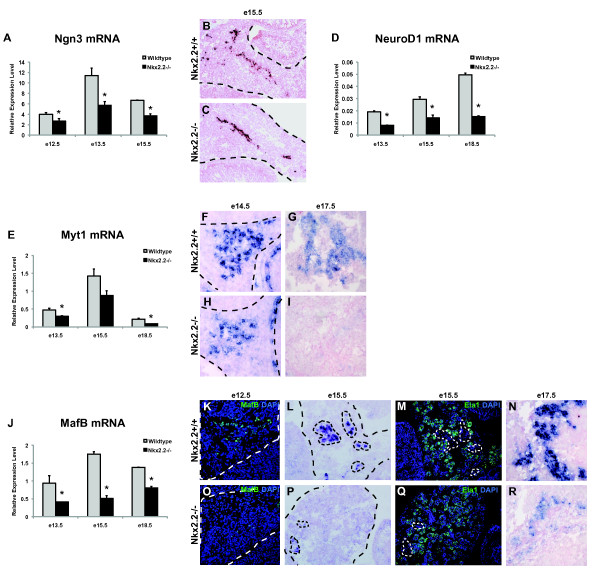
Loss of Nkx2.2 affects expression of critical early endocrine progenitor transcription factors; Ngn3, NeuroD1, Myt1, and MafB. qRTPCR of (A) Ngn3 levels were assessed at e12.5, e13.5, and e15.5; (D) NeuroD1, (E) Myt1, and (J) MafB transcript levels were determined at e13.5, e15.5, and e18.5 and all genes compared wild type (grey bars) and Nkx2.2-/- pancreata (black bars). In situ hybridization comparing wild type and Nkx2.2-/- pancreas at e15.5 of Ngn3 (B and C), at e14.5 and e17.5 of Myt1 (F, G, H, and I), at e15.5 and e17.5 of MafB (L, N, P, and R). Immunofluorescence staining of MafB (green) was compared between wild type (K) and Nkx2.2 null (O) pancreata at e12.5. Immunofluorescence staining of Ela1 (green) on adjacent sections at e15.5 shows restriction to the endocrine compartment (M and Q). DAPI (blue) represents nuclei. Error bars represent SEM and asterisks denote statistical significance < 0.05. Magnification 20× for all except N and R, which are 40×. Large dashed lines outline the pancreas at e12.5, e14.5 and e15.5. Small dashed lines outline MafB expression.